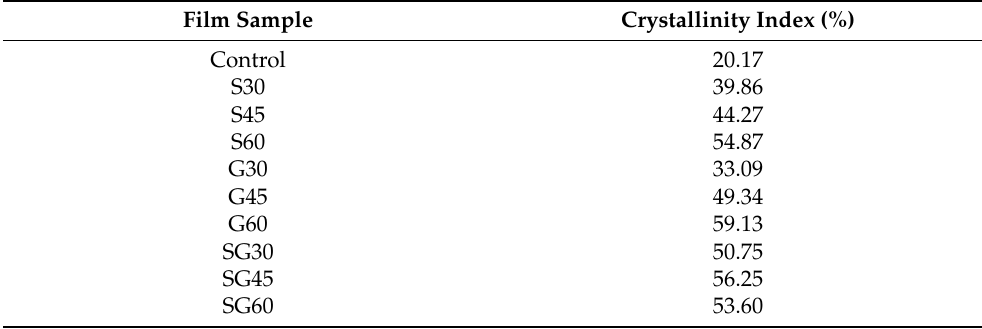
Table 3. Crystallinity index of CS